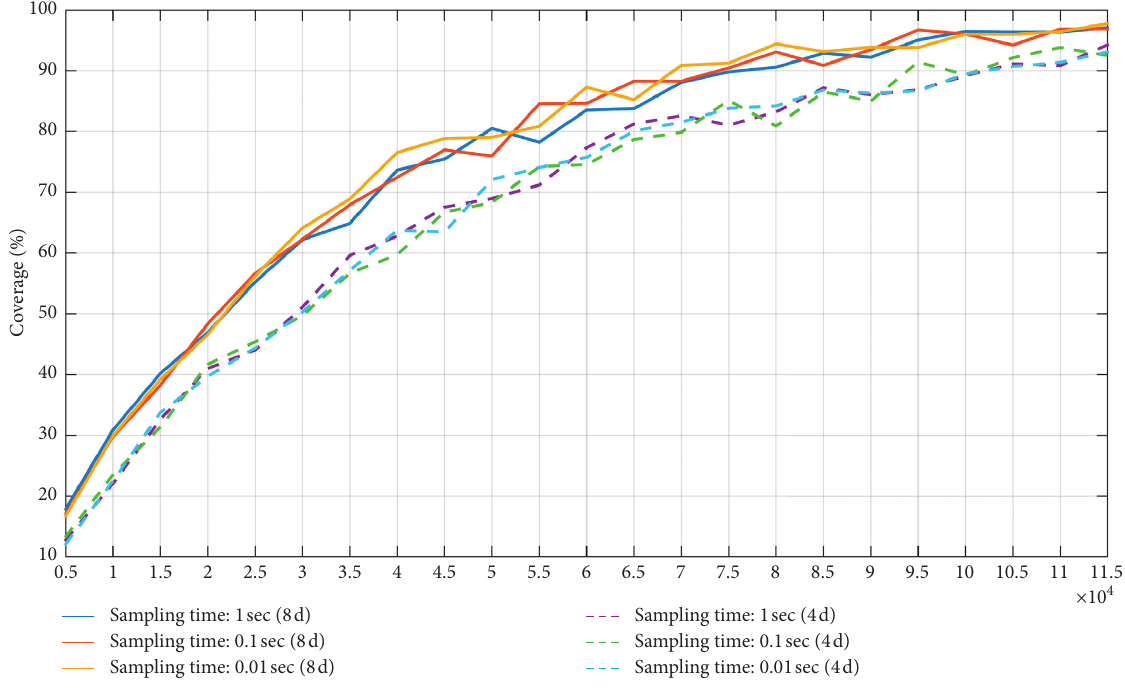
Figure 18: Coverage versus number of iterations. Table 1: Curve fitting for coverage.